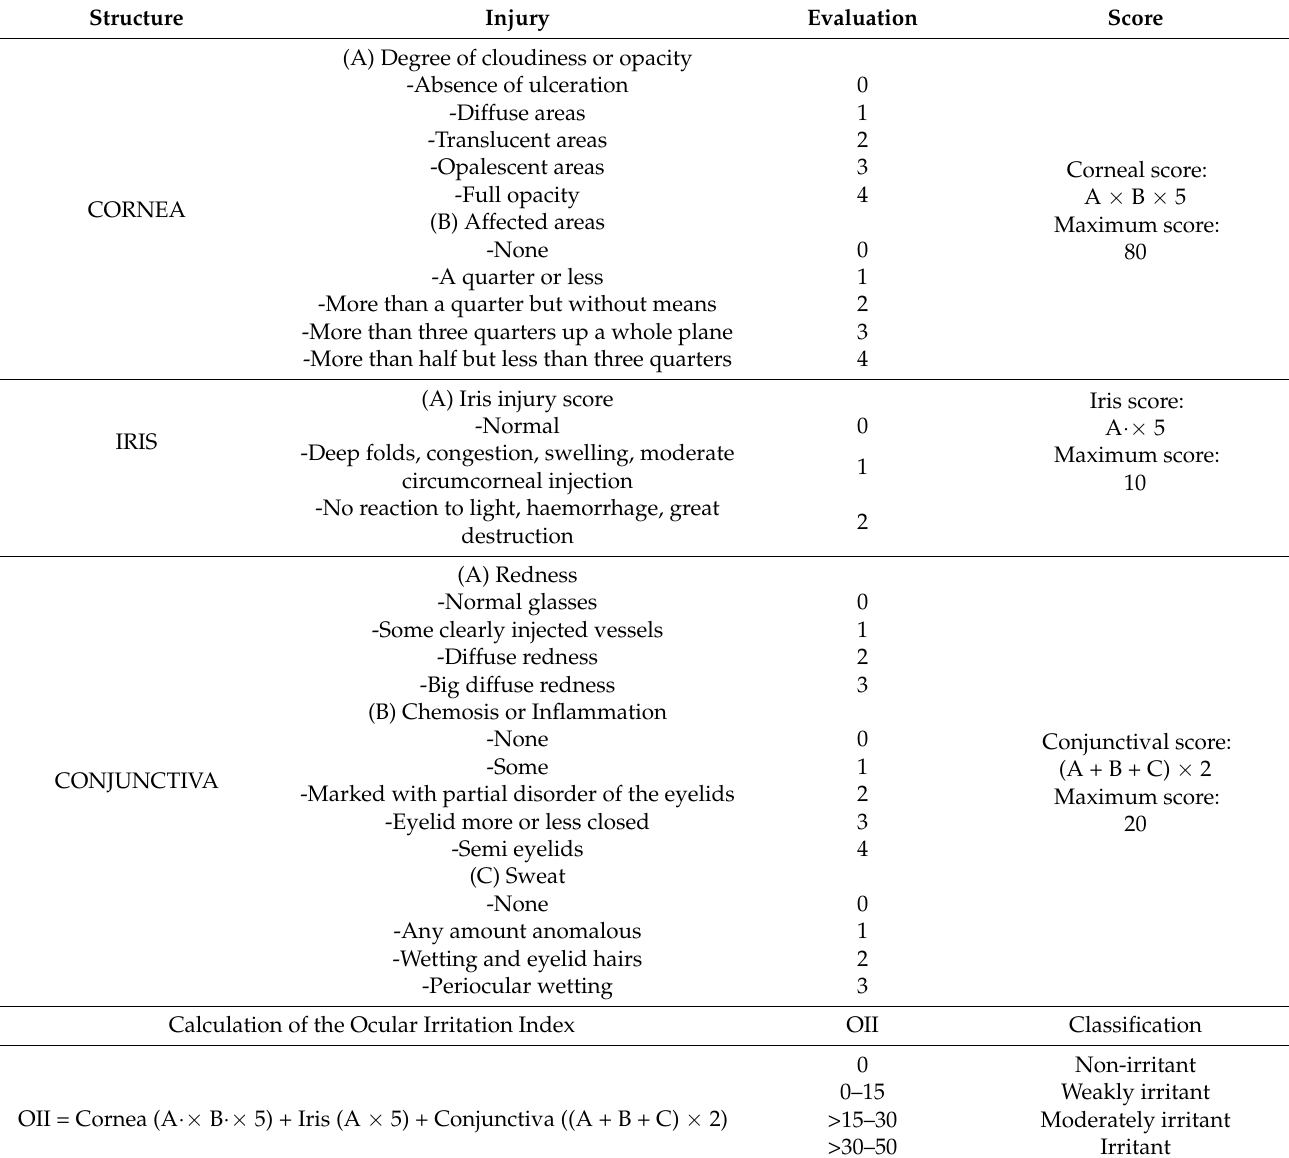
Table A1. Rating scale to evaluate the degree of ocular irritation (Draize